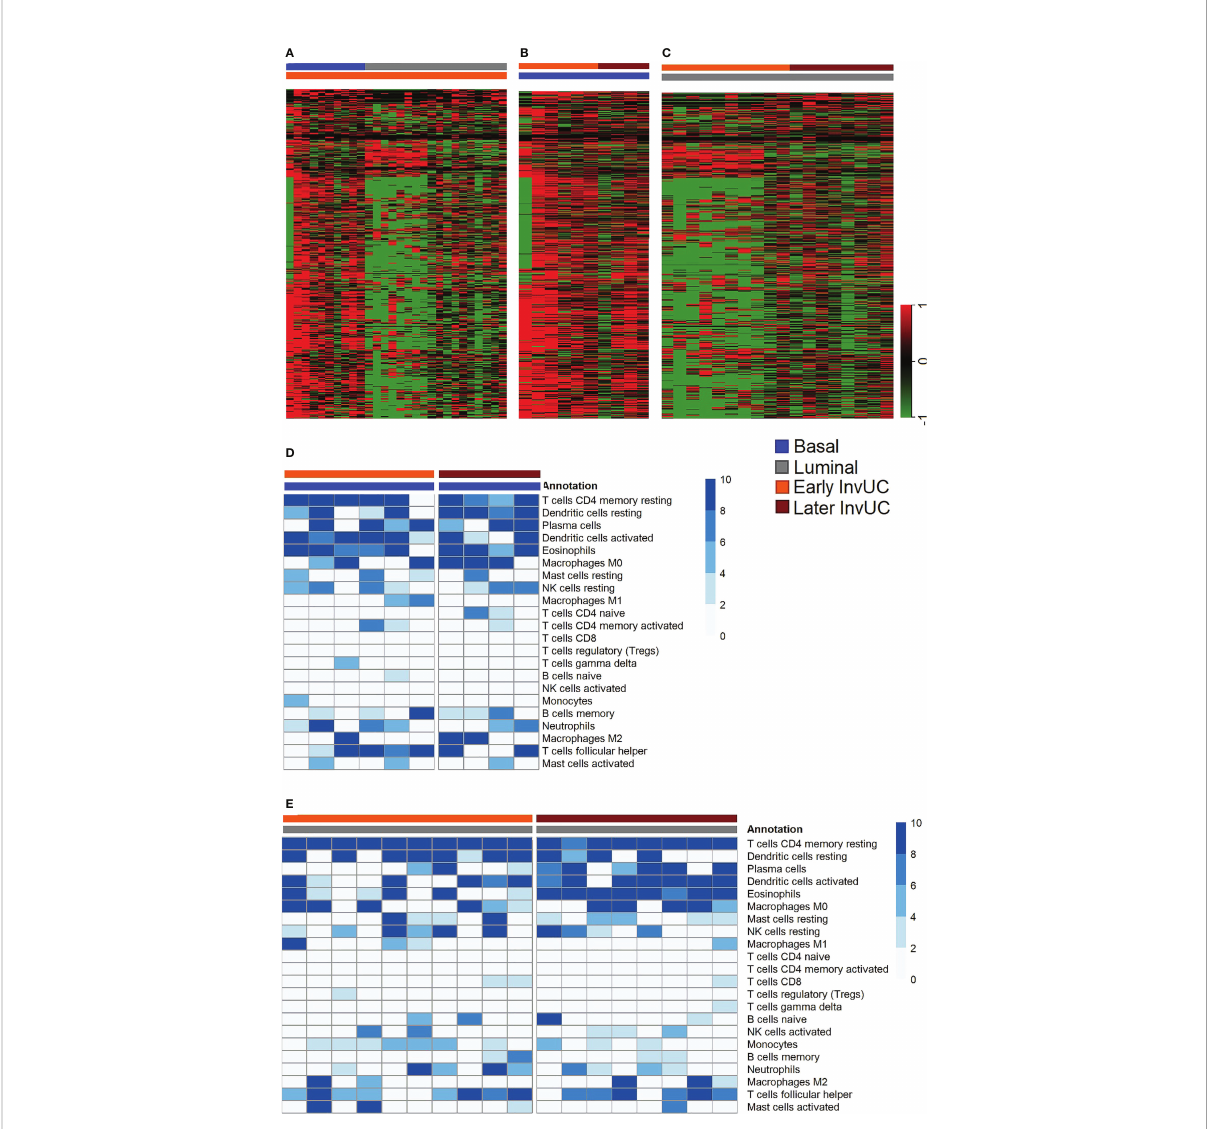
FIGURE 6 RNA-seq immune signatures in early and later canine invasive urothelial carcinoma (InvUC). Previously reported genes known to predict T-cell in fl ammation in human InvUC were used to identify immune in fi ltration (immune hot) or lack of immune in fi ltration (immune cold) signatures in early and later canine InvUC (A-C) . The heatmaps in A-C were constructed to denote cold immune signatures in green, and hot signatures in red (52). Note that early basal tumors were much more immune hot than early luminal tumors (A) . Early and later basal tumors were similar in immune in fi ltration signatures (B) . Later luminal tumors were less immune cold than early luminal tumors (C) , but were still less hot than basal tumors. The expected heterogeneity is observed within and between samples. In CIBERSORT analyses, the types of immune cells responsible for the immune signatures were similar between subtypes and time points (D, E)